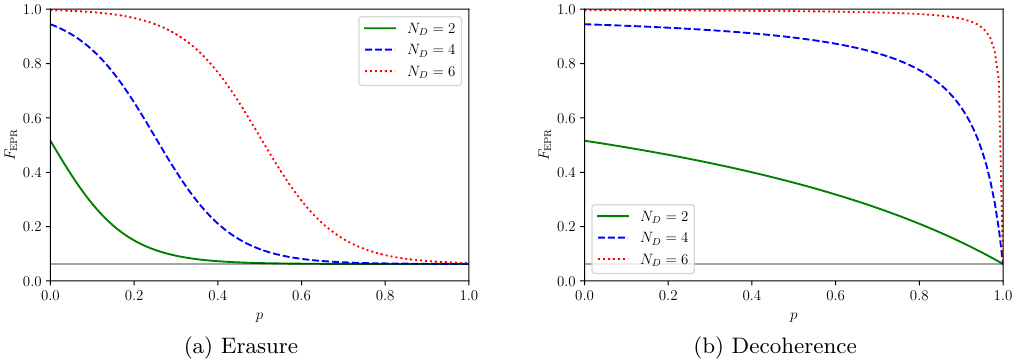
Figure 3 . Error-probability dependence of the decoding fidelity in the presence of (a) erasure errors and (b) decoherence. The sizes of total system and Alice’s state are fixed to be N = 10 and N A = 2 , respectively. The black solid horizontal line indicates the lower bound of decoding fidelity, 1 /d 2 . The erasure errors severely affect the decoding fidelity compared while the it is well A protected against the decoherence effect particularly when N D is large relative to N A .